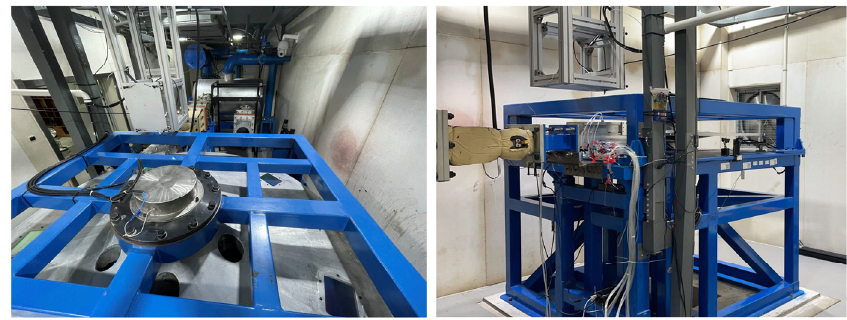
Figure 16. Overall CAD model of the experimental facility.